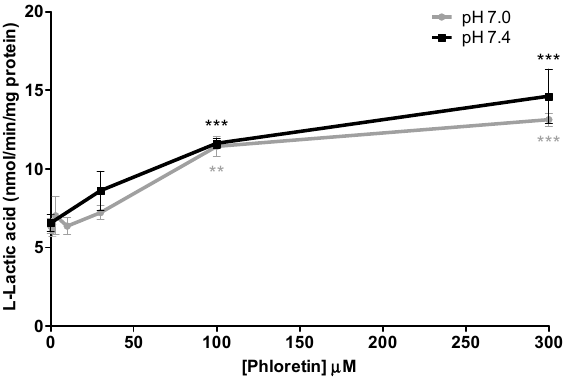
Figure 7. Inhibitory effects of phloretin, a known MCT inhibitor, on L -lactic acid efflux in SkMC. The intracellular [ 14 C] L -lactic acid was measured after 2.5 min of efflux at pH 7.0 and pH 7.4 (** p < 0.01 and *** p < 0.001).